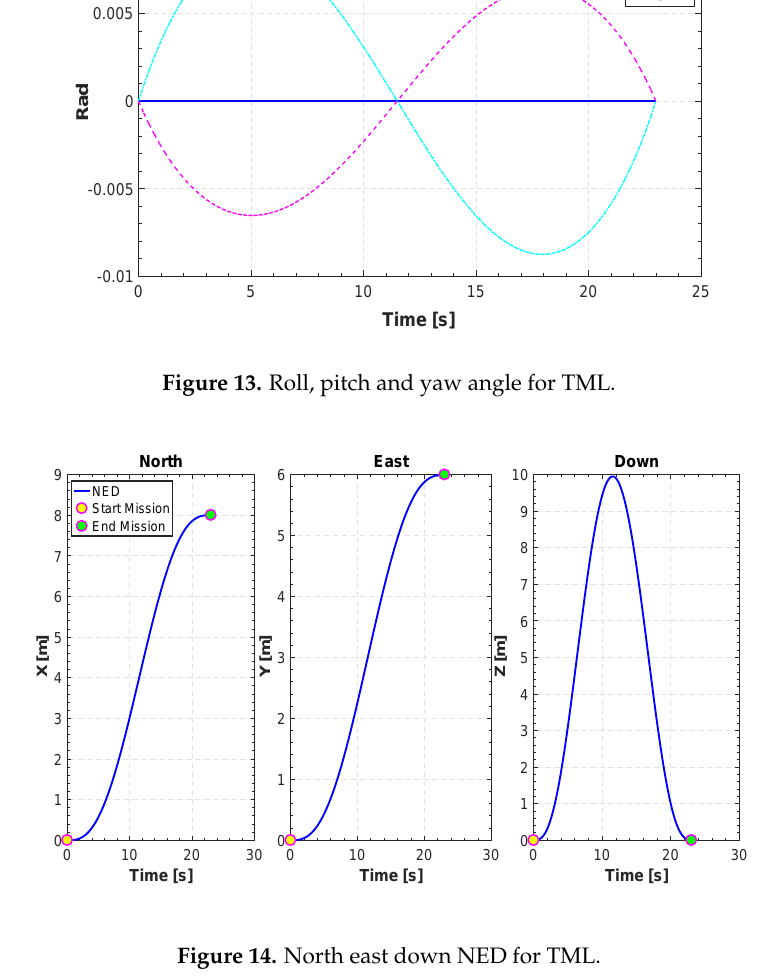
Figure 14. North east down NED for TML.